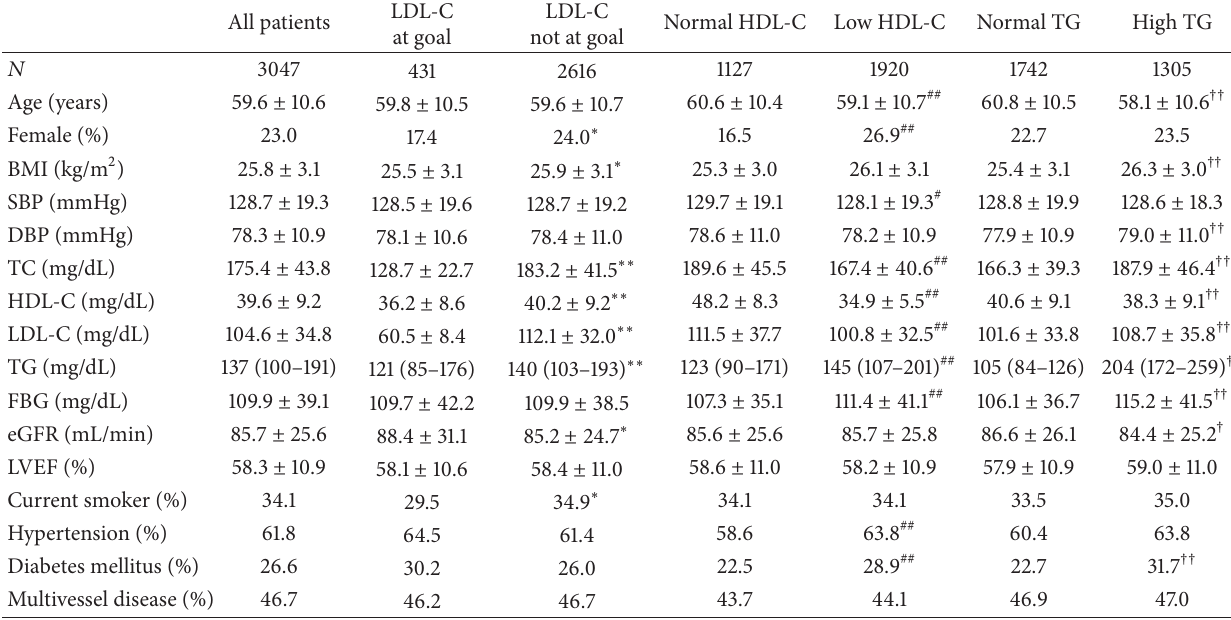
Table 1: Patient characteristics, risk categories, and lipid parameters.